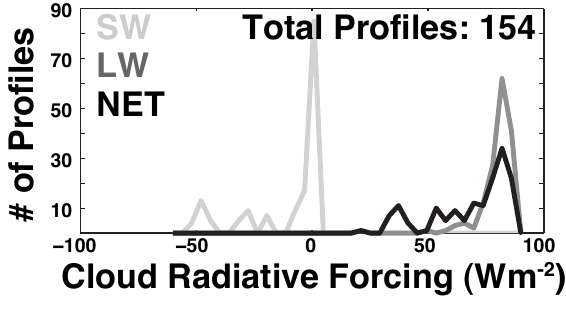
Table 2. Mean cloud radiative forcing for M-PACE mixed-phase